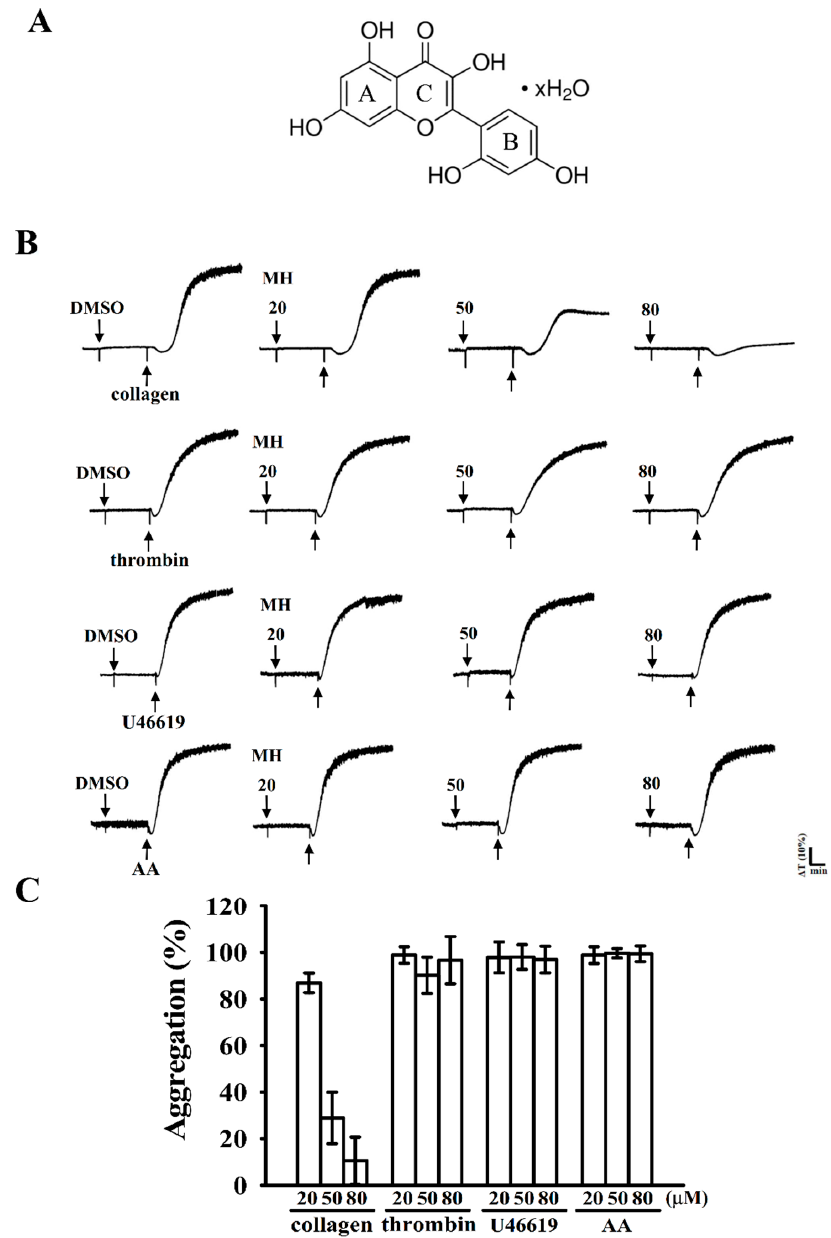
Figure 1. Inhibitory activity of morin hydrate in platelet aggregation stimulated by various agonists in washed human platelets. ( A ) Chemical structure of morin hydrate; ( B ) washed human platelets (3.6 × 10 8 cells/mL) were preincubated with the solvent control (0.1% dimethyl sulfoxide, DMSO) or morin hydrate (20, 50, and 80 µ M) and subsequently treated with 1 µ g/mL of collagen, 0.01 U/mL of thrombin, 1 µ M of U46619, and 60 µ M of arachidonic acid (AA) to stimulate platelet aggregation; ( C ) concentration–response histograms of morin hydrate in inhibition of platelet aggregation (%). All data are presented as means ± standard errors of means ( n =